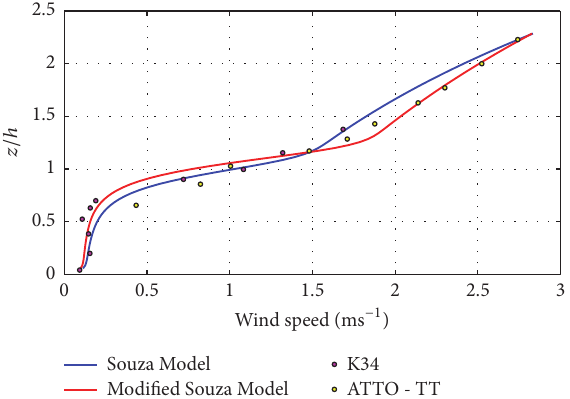
Figure 4: Observed and modeled vertical wind profiles.